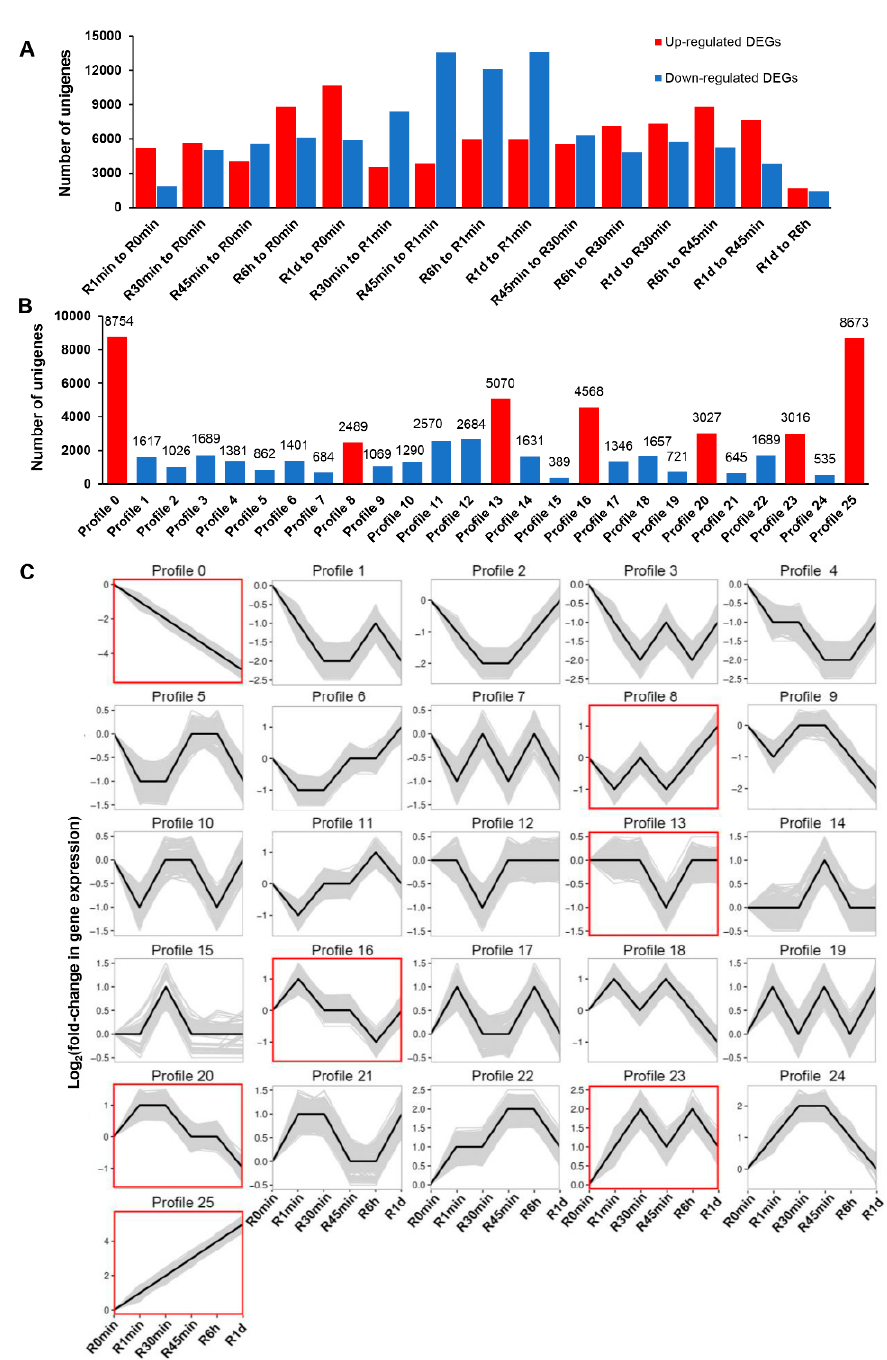
Figure 5. Summary of R canescens differentially expressed genes (DEGs) during the rehydration process: ( A ) number of DEGs between the indicated time points during rehydration; ( B ) number of DEGs associated with each cluster: red columns indicate significant clusters calculated by Short Time-Series Expression Miner software with a Q -value ≤ 0.05; ( C ) expression patterns of genes across all 26 clusters. Significant clusters have a red border.